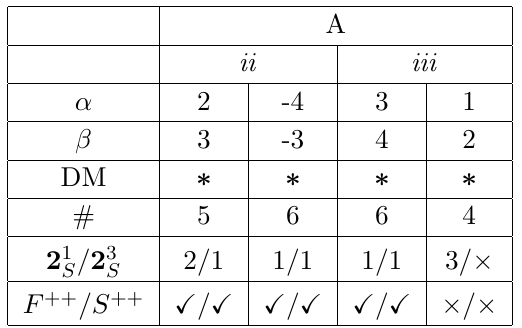
Table 10. Realizations of diagram 2.a of (cid:12)gure 2. For each set of SU ( 2 ) L quantum numbers (roman numerals) and Z 2 assignments (capital letters A, B, C) we give the hypercharge in terms of (cid:11) and (cid:12) parameters, the DM candidates, the number of BSM particles (#), the number of 2 1 as well as the existence (or not) of doubly-charged fermions ( F ++ ) and doubly-charged scalars ( S ++ ) particles. The symbol X ( (cid:2) ) means present (absent) while the symbol (cid:3) , if present in the DM row, means mixing between 1 0 and 2 1 . The SU ( 2 ) L , Z 2 and U ( 1 ) Y assignments are given in table S S